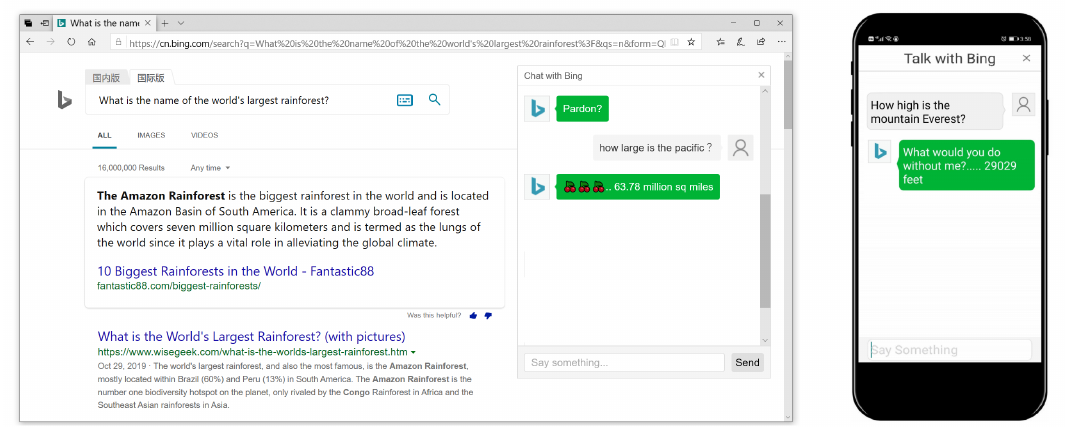
Figure 1. Examples of machine reading comprehension applied to search engine and dialogue